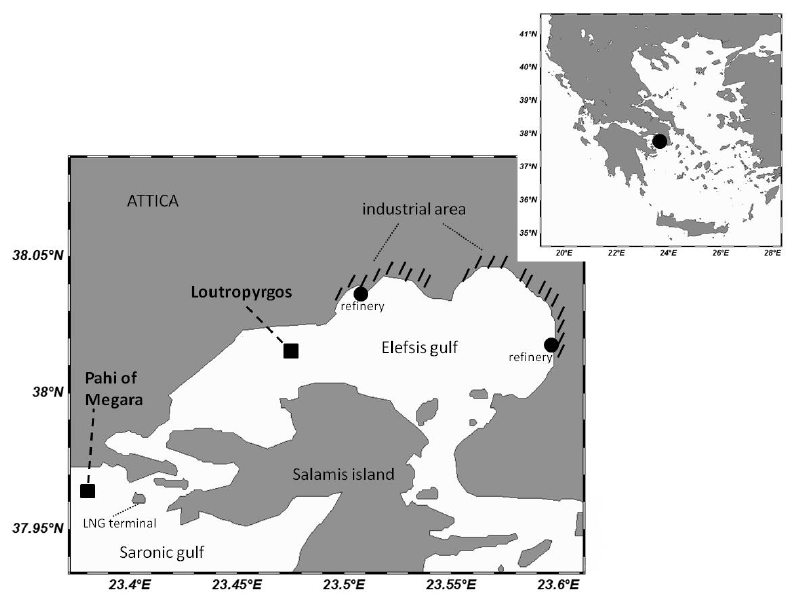
Figure 1. Sampling sites within the Gulf of Elefsis, Greece (Schlitzer, Reiner, Ocean Data View, odv.awi.de, accessed on 7 November 2021).